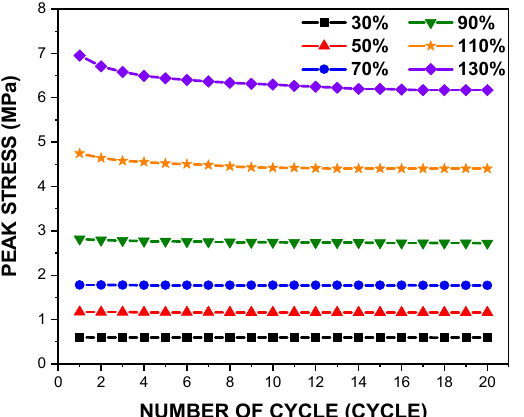
Figure 5. Deviations in the peak stress of the PDMS film with a thickness of 150 µ m over the cyclic tensile loading cycles.